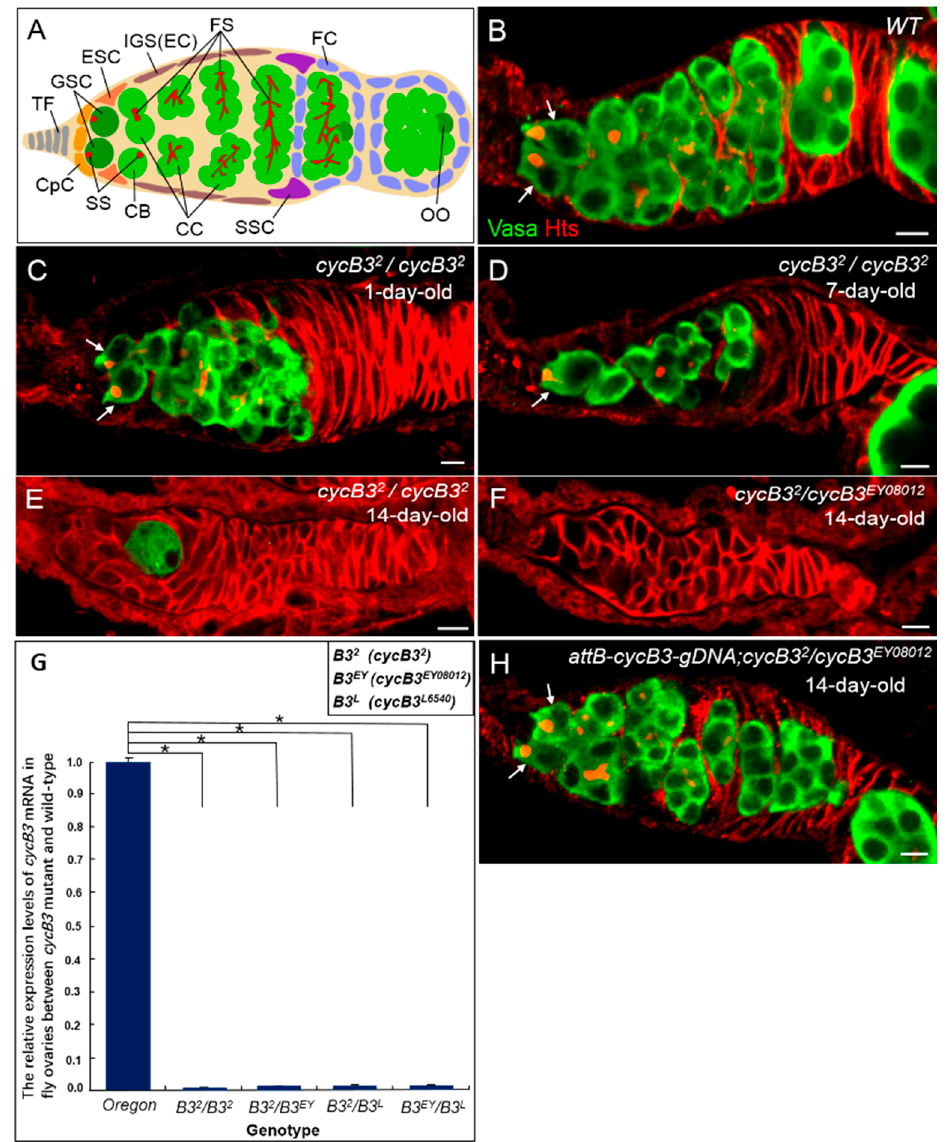
Figure 1. cycB3 is required for maintaining GSCs in the Drosophila ovary. ( A ) A cross-sectional diagram of an adult Drosophila germarium; ( B – F , H ) germaria labeled with anti-Vasa antibody (green, germ cells), and with anti-Hts antibody (red, fusomes and spectrosomes). GSCs are indicated by arrows. ( B ) Wild-type germarium with two GSCs; ( C – F ) cycB3 mutant ovaries on different days after eclosion. Germaria, containing two GSCs ( C ); one GSC ( D ); no GSCs ( E ) and an empty germarium ( F ); ( G ) Quantitative real-time PCR analyses of cycB3 mRNA levels in ovaries between wild-type and cycB3 mutants; ( H ) The transgene P{ attB - cycB3-gDNA } rescued the cycB3 2 / cycB3 EY 08012 mutant ovary to normal. Scale bars: 5 μ m. * p < 0.001. Abbreviations: Terminal filament (TF), Germline stem cell (GSC), Escort stem cell (ESC), Inner germarium sheath cell (IGS) or Escort cell (EC), Fusomes (FS), Follicle cell (FC), Cap cell (CpC), Spectrosomes (SS), Cystoblast (CB), Cyst cell (CC), Somatic stem cell (SSC), OO(oocyte).